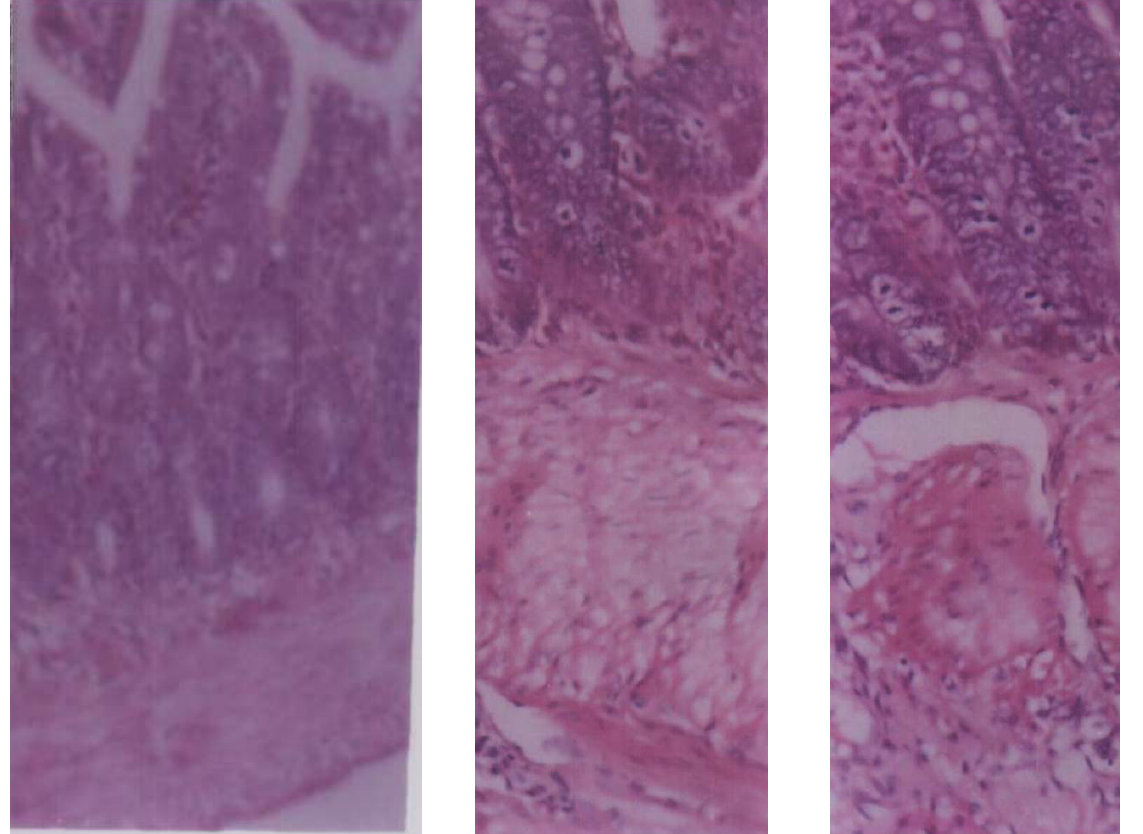
FIGURE 2 - Photomicrographs of the local inflammatory response in the studied groups (100X)